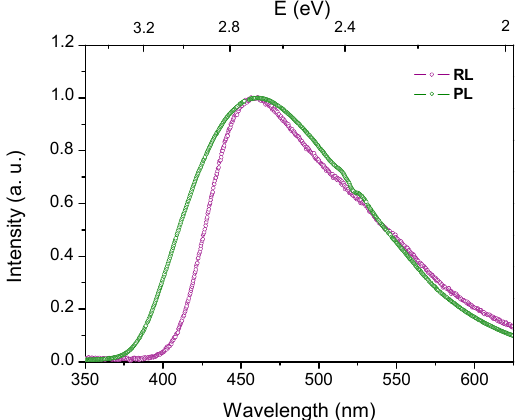
Figure 9. Ce-doped optical fiber responses: normalized typical RL spectrum and the PL one obtained under 320 nm